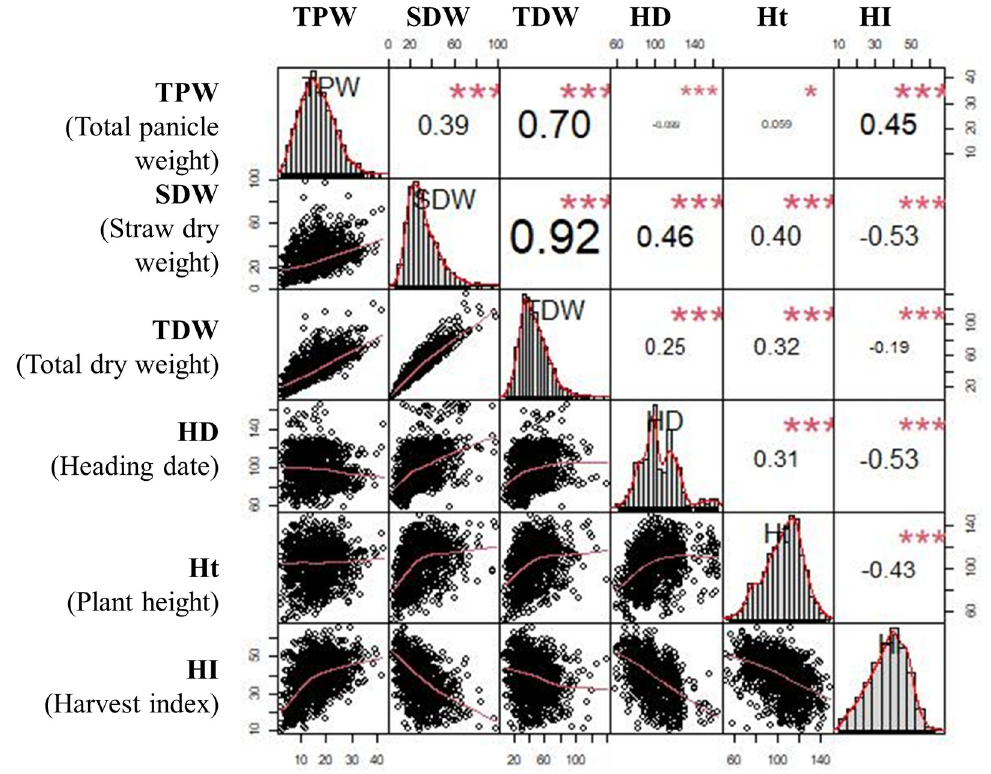
Fig 2. Scatterplots showing the relationship among all evaluated agronomic traits. The distribution of each variable is shown on the histogram, while the bivariate scatter plots with a fitted line, and correlation values and significance level are shown on the left and right side, respectively. Significance level: p-values (p < 0.001: ��� , p < 0.01: �� , p < 0.05: � , p > 0.05: